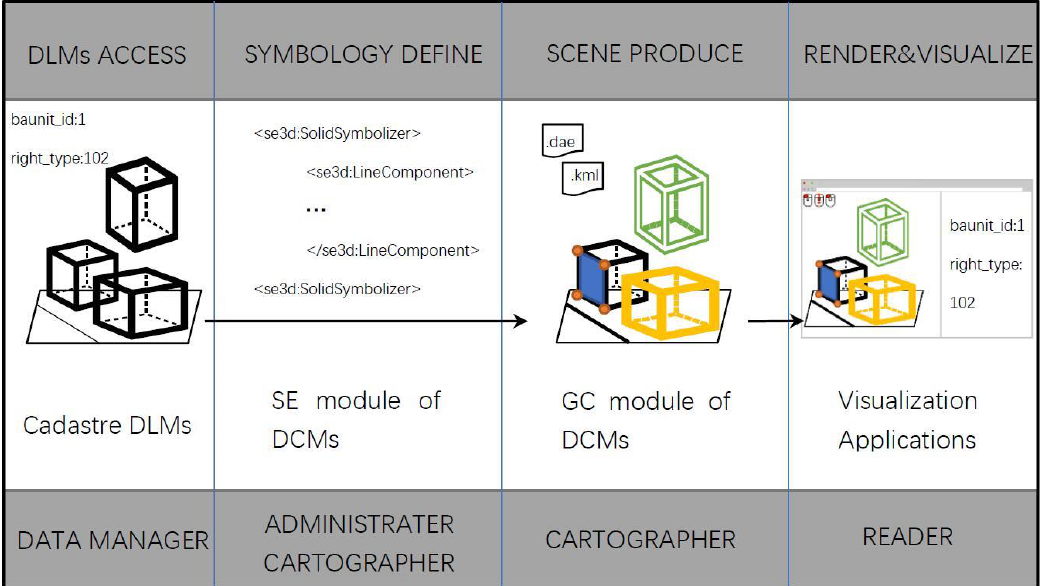
Figure 6. The DCM-based 3D cadastre visualization pipeline. In this pipeline, the DLM is the geometric and semantic 3D cadastre data. DCMs describe the mechanism of the feature selection, the symbolic rule encoding, and the 3D content encoding. The pipeline contains four steps and, in each step, involves different user groups.